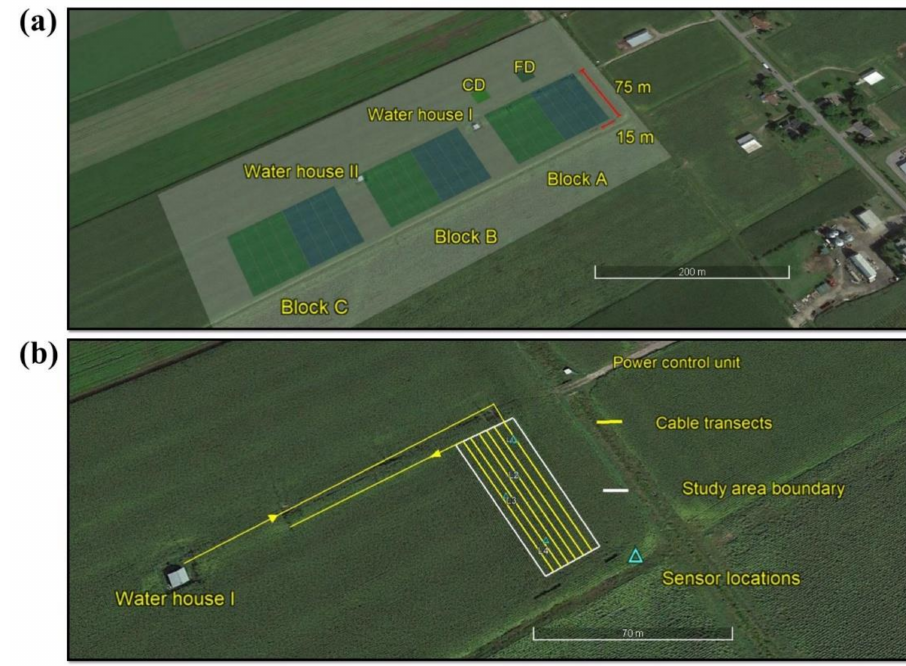
Figure 1. ( a ) Shows the study area which consists of three main blocks A, B and C. Blue and green rectangles within the main block are sub plots (15 × 75 m) of free drainage (FD) and controlled drainage (CD), respectively. Two water houses facilitate the measurement of drainage volume from each sub plot; ( b ) shows the fiber optic cable configuration in the field. Cable connected to the Distributed Temperature Sensing (DTS) instrument starts from the water house I and runs through two subplots at three depths (0.05, 0.10 and 0.20 m), blue rectangles show the locations of 5TE soil moisture sensors used for calibration and